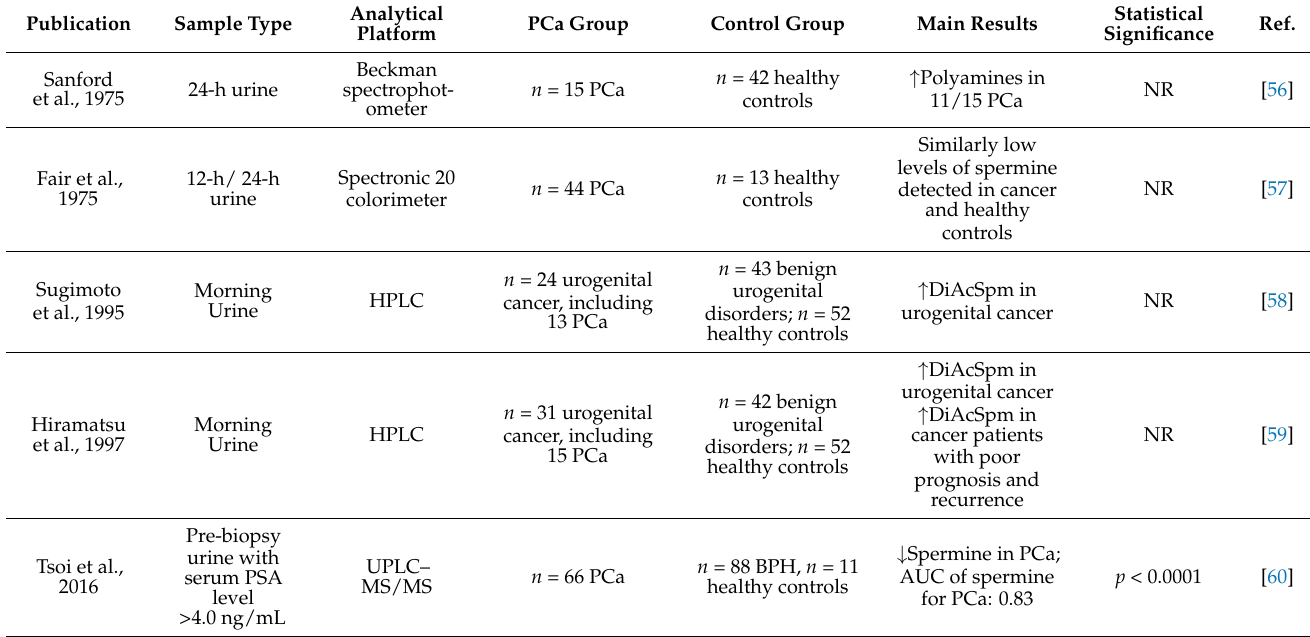
Table 1. Spermine studies performed in urine/tissues/EPS/erythrocyte from PCa